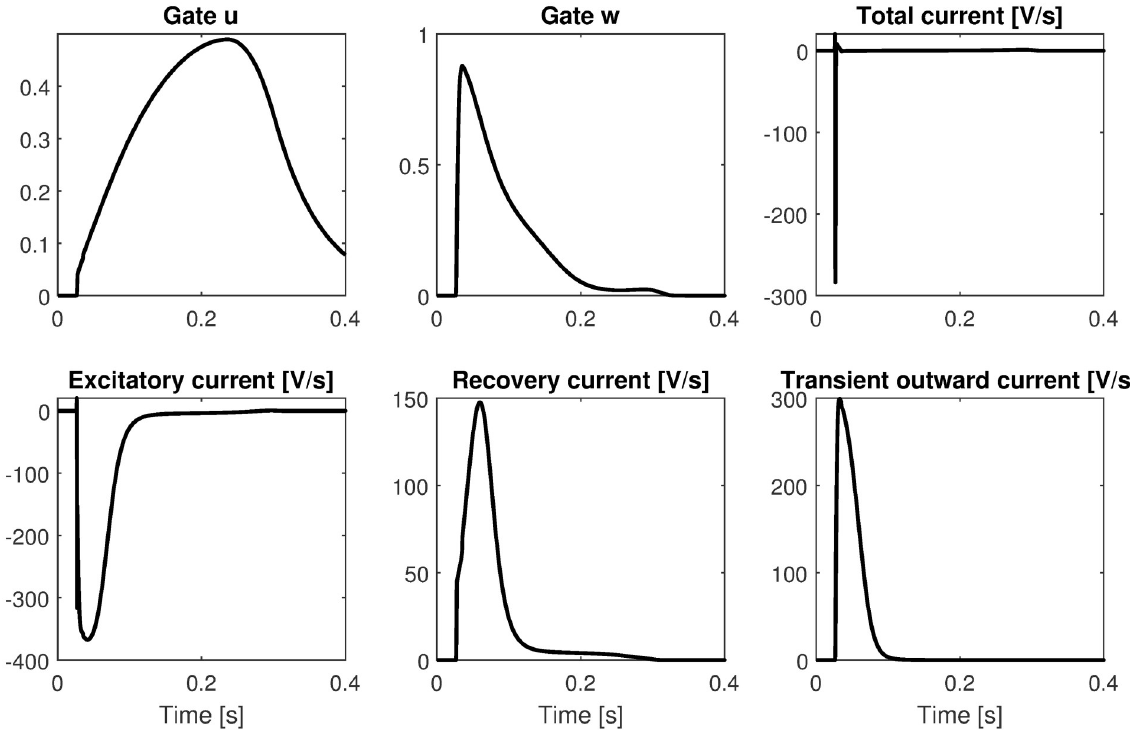
Fig 3. Time course of the gate variables and the ionic currents in one-dimensional cable. First row shows the time course of the two gate variable and the total ionic current. Second row shows the three contributions to the total ionic current.